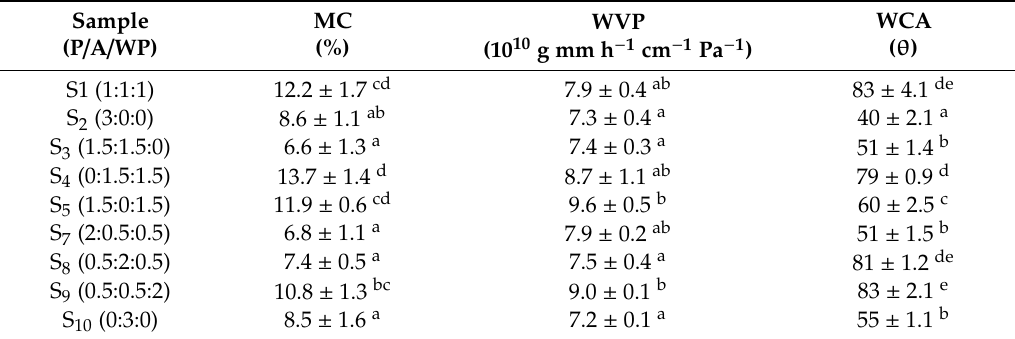
Table 5. Moisture content (MC), water vapor permeability (WVP) and Water contact angle (WCA) of composite